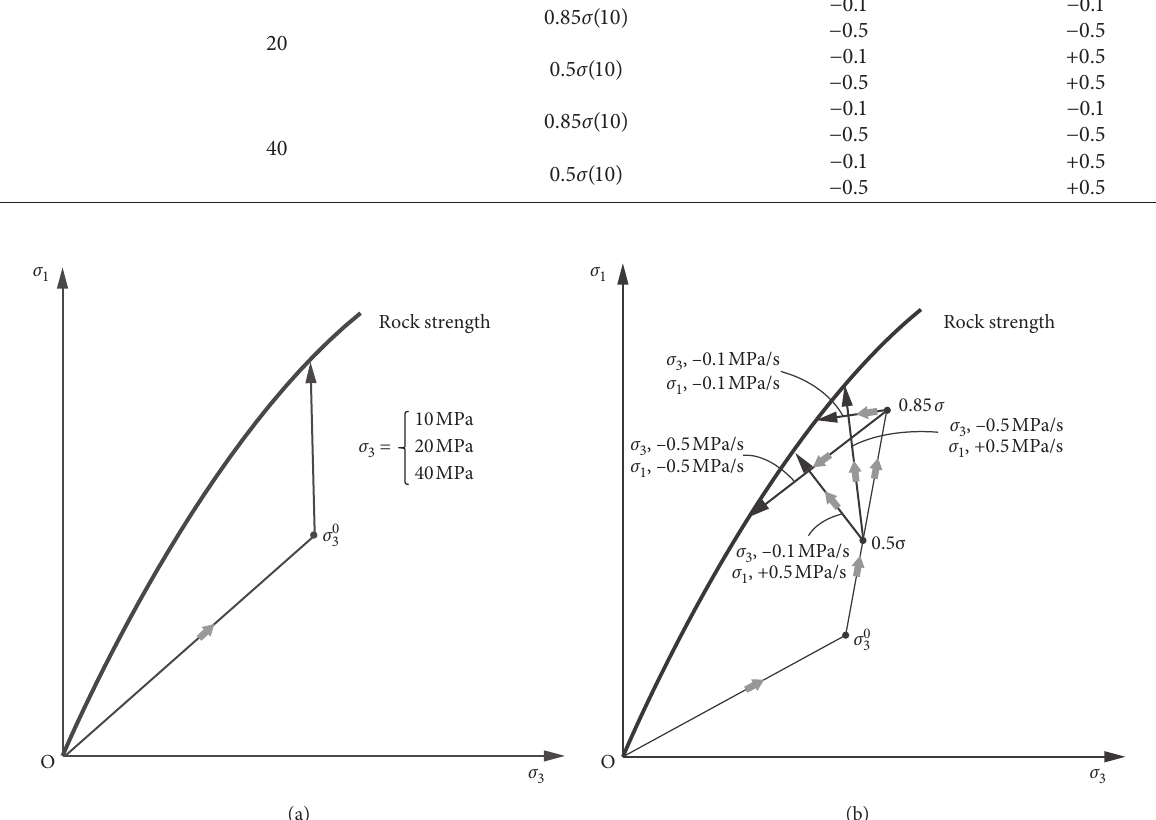
Figure 2: Schematic diagram of the tested stress paths: (a) conventional triaxial tests; (b) complex loading-unloading stress tests.